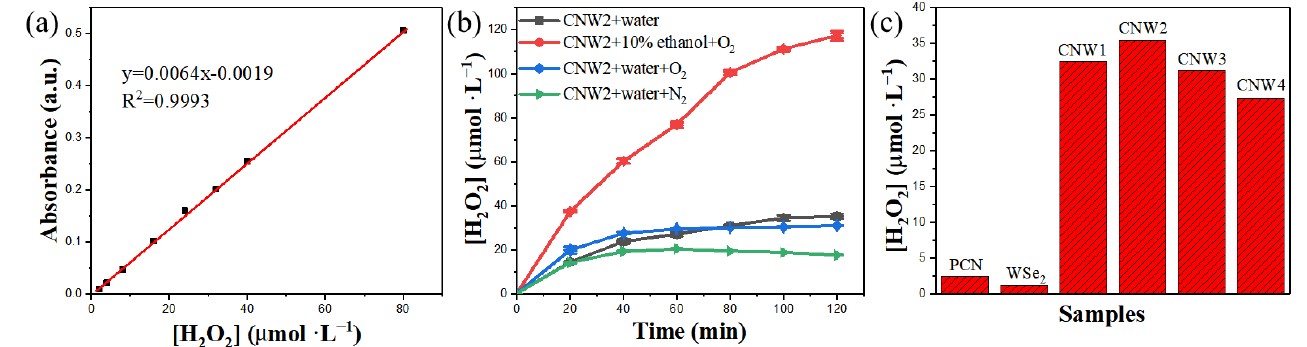
Figure 7. ( a ) Standard curve of the concentration of H 2 O 2 and its absorbance, ( b ) photocatalytic H 2 O 2 production profiles on various samples under visible light irradiation, and ( c ) maximum yield of H 2 O 2 on various samples under visible light irradiation. of H 2 O 2 on various samples under visible light irradiation.